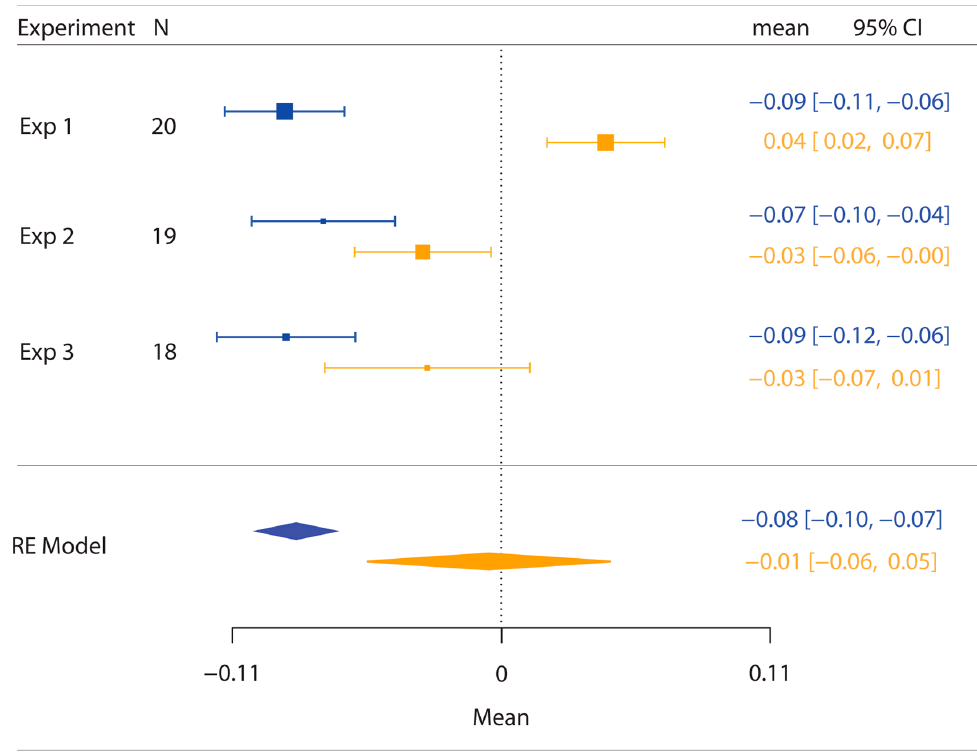
Figure 6. Plot of the results of the comparison across the three experiments of the PSE values for the posts (blue) and objects (orange) stimulation conditions. N represents the number of participants in each experiment. Error bars represent the 95% confidence interval (CI), which is reported on the left side of the graph for each condition across experiments in different colours. The random-effects model (RE Model) showed that the PSE for the posts condition is significantly lower than zero ( p < 0.0001), whereas the PSE for the objects condition does not differ from zero ( p = 0.8424). Note that differently from the graphs for the single experiments, here, the data are not plotted in log format.